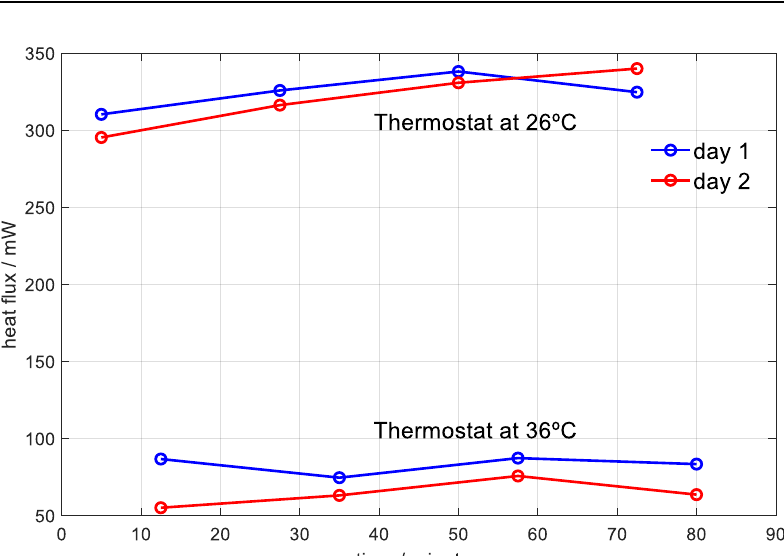
Table 6. Results of measurements made on the right hand in the senior subject in two different days (day 1: T room = 21.3 ºC, day 2: T room = 21.8 ºC). Measure day